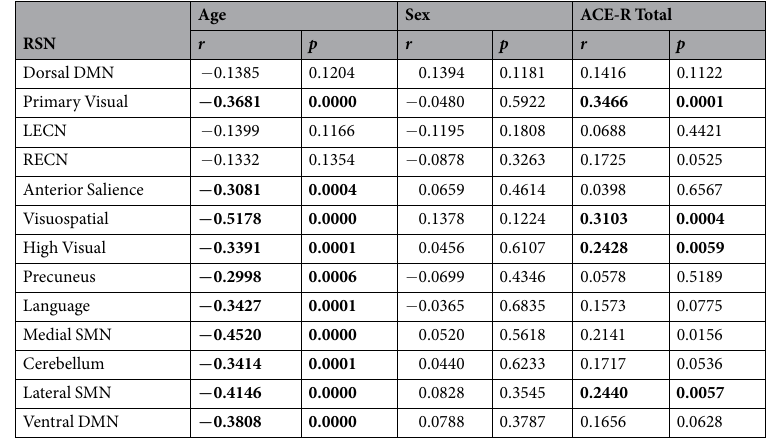
Table 1. Partial correlation values r of the similarity measure η 2 with age, sex, and ACE-R total score using reference RSNs constructed from the mean subject-specific RSNs of the young subgroup of participants (age < = 30 years old). Highlighted p -values are significant after correction for multiple comparisons using 5% false discovery rate (FDR q < 0.05). RSN – resting state network, DMN – default mode network, LECN – left